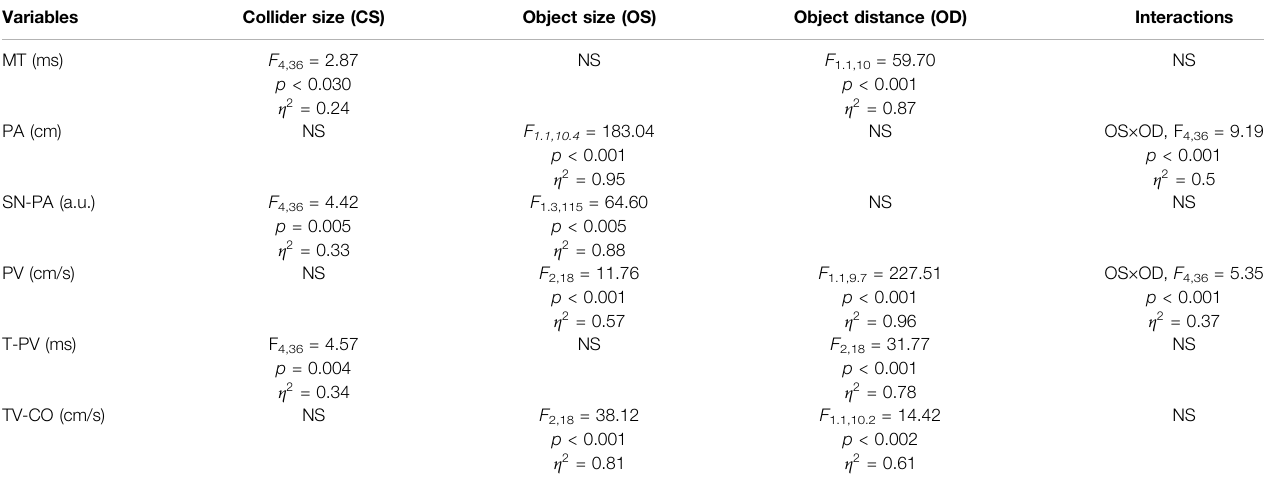
TABLE 3 | Outcomes of 5 × 3 × 3 rm-ANOVAs examining the effects of collider size (0.2, 0.4, 0.8, 1.2, and 1.4), object size (small, medium, and large), and object distance (near, middle, and far) on each kinematic variable in Study 2. Variables